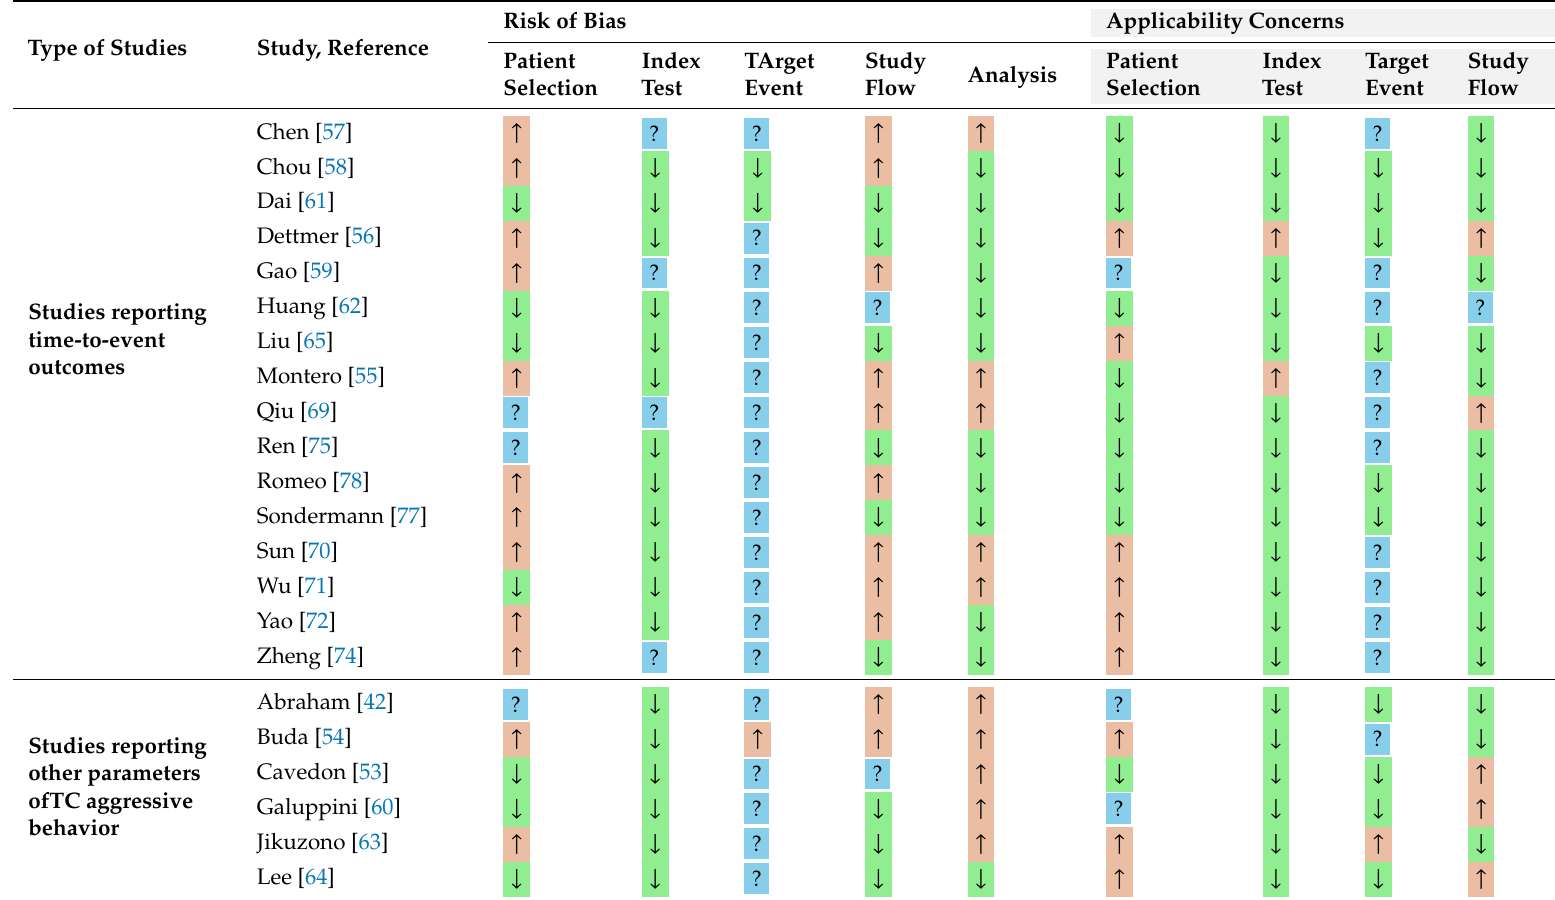
Table A2. ‘Risk of bias’ and ‘Applicability concerns’ assessment according to QUAPAS by the outcome. Type of